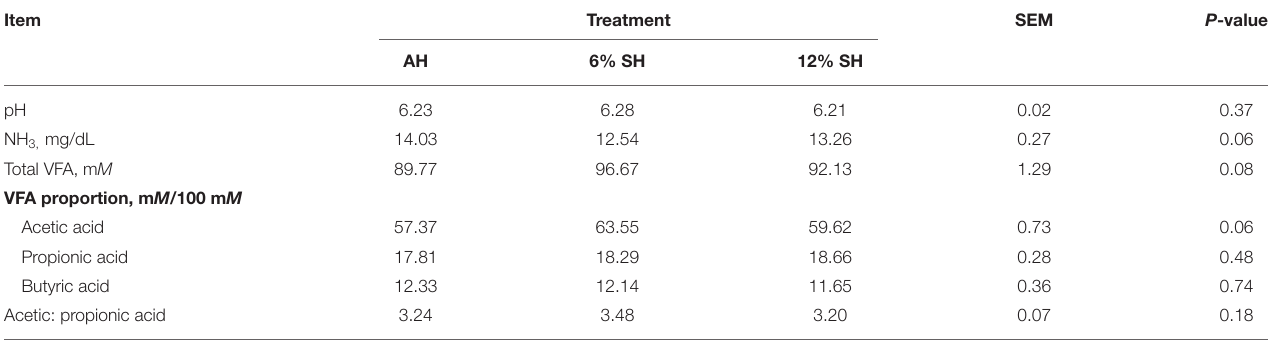
TABLE 6 | Effect of partial substitution of alfalfa hay by stevia hay on ruminal pH, NH 3 , and volatile fatty acids